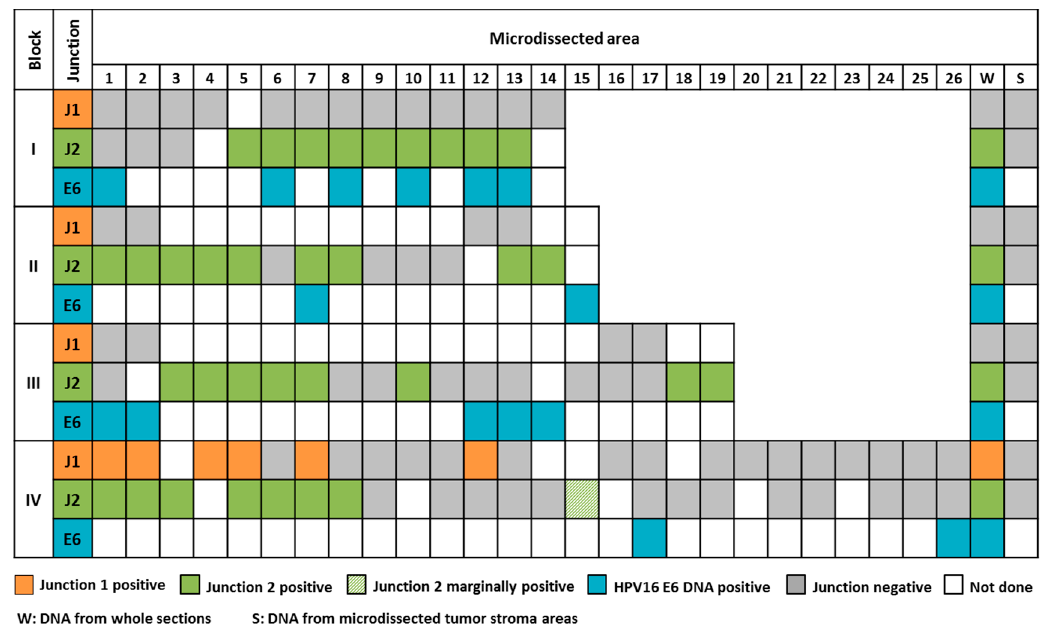
Figure 2. Varying numbers of areas were micro-dissected from four blocks of tumor 4977 and submitted to junction-specific PCR. Areas tested for the presence of both junctions received identical numbers. Successful detection is indicated by color. Both junctions are heterogeneously detected throughout the four blocks. Junction 1 is present in block IV only whereas junction 2 is detectable in all blocks, but not in all areas.